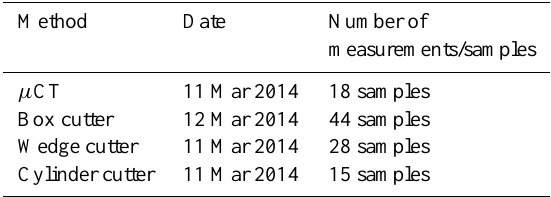
Table 3. Date of measurements and number of measure- ments/samples for the instruments used in the